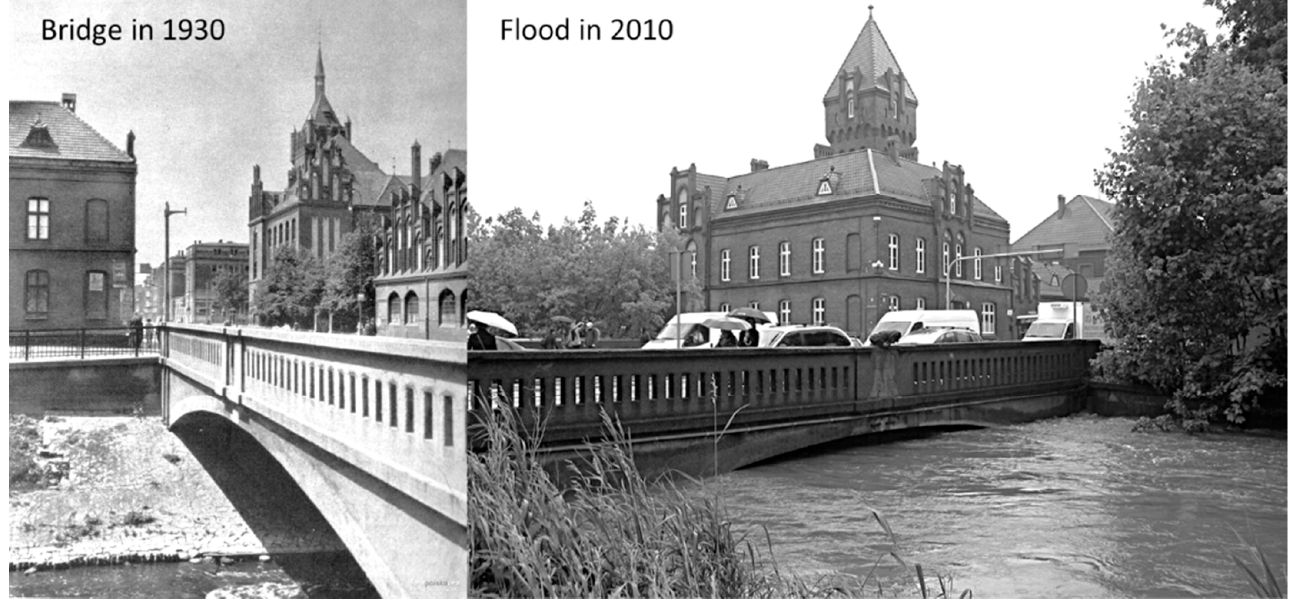
Figure 2. View of the bridge in 1930 and during a flood in 2010 [77].